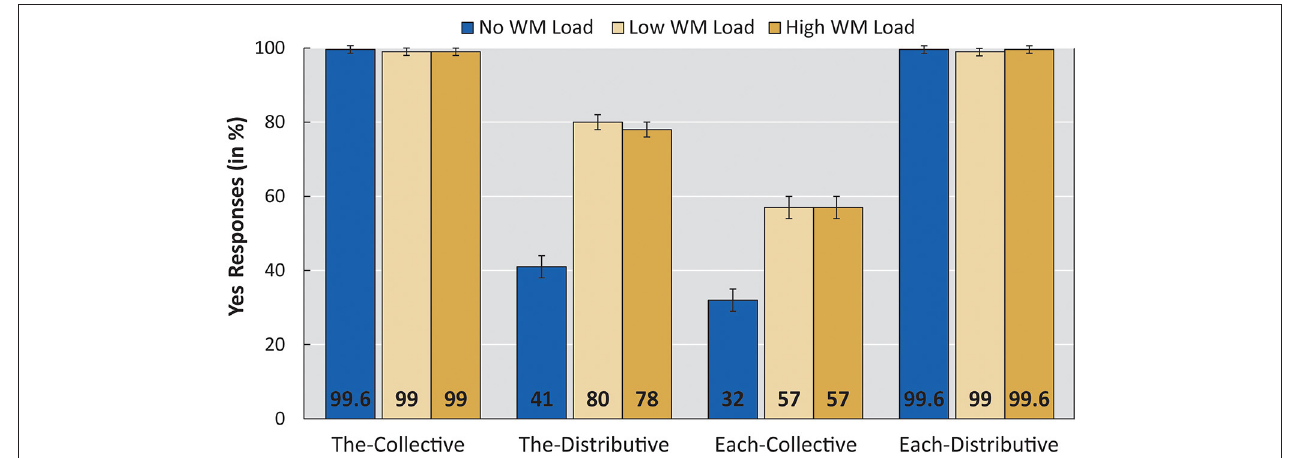
FIGURE 3 | Mean acceptance rates per linguistic condition per WM load (No load, Low, High). Error bars show standard error. The WM Load group was tested with Low and High WM load; the No WM load group was tested on the linguistic task only. Sentences contained either de “the” or elke “each” and pictures showed either a collective action or a distributive action.